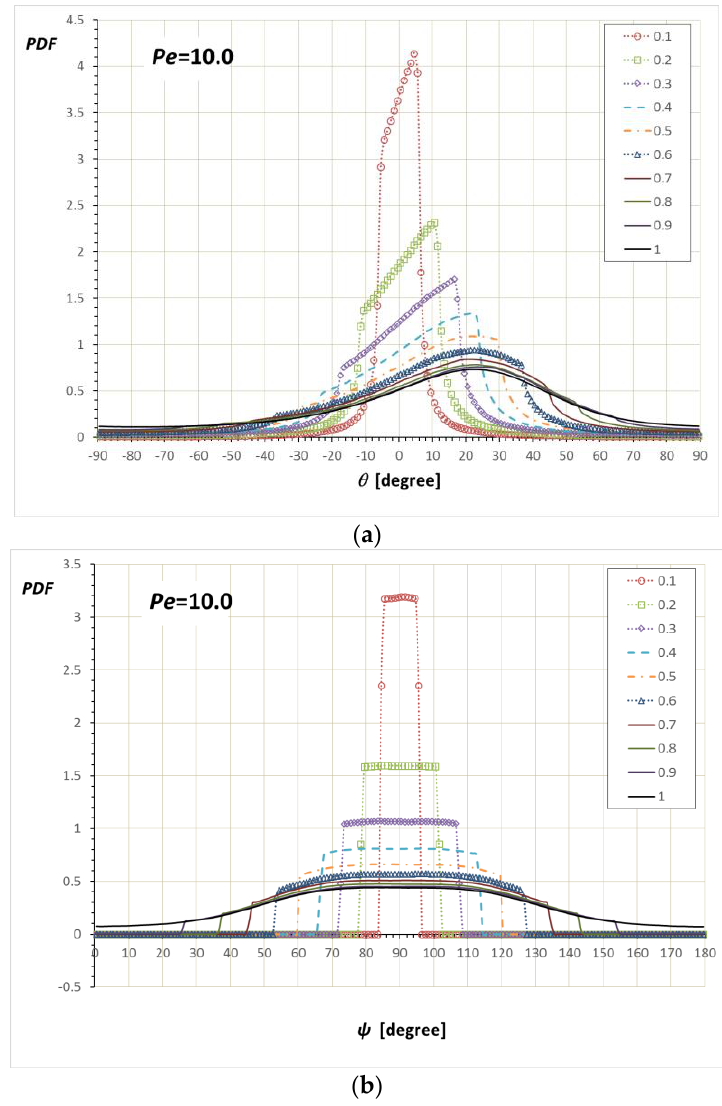
Figure 10. Simulation results for the ( a ) PDF( θ ) and ( b ) PDF( ψ )/sin ψ at Pe = 10 with various α / a . It is seen that θ max ≈ 25°, which corresponds to α = 0.43 a .